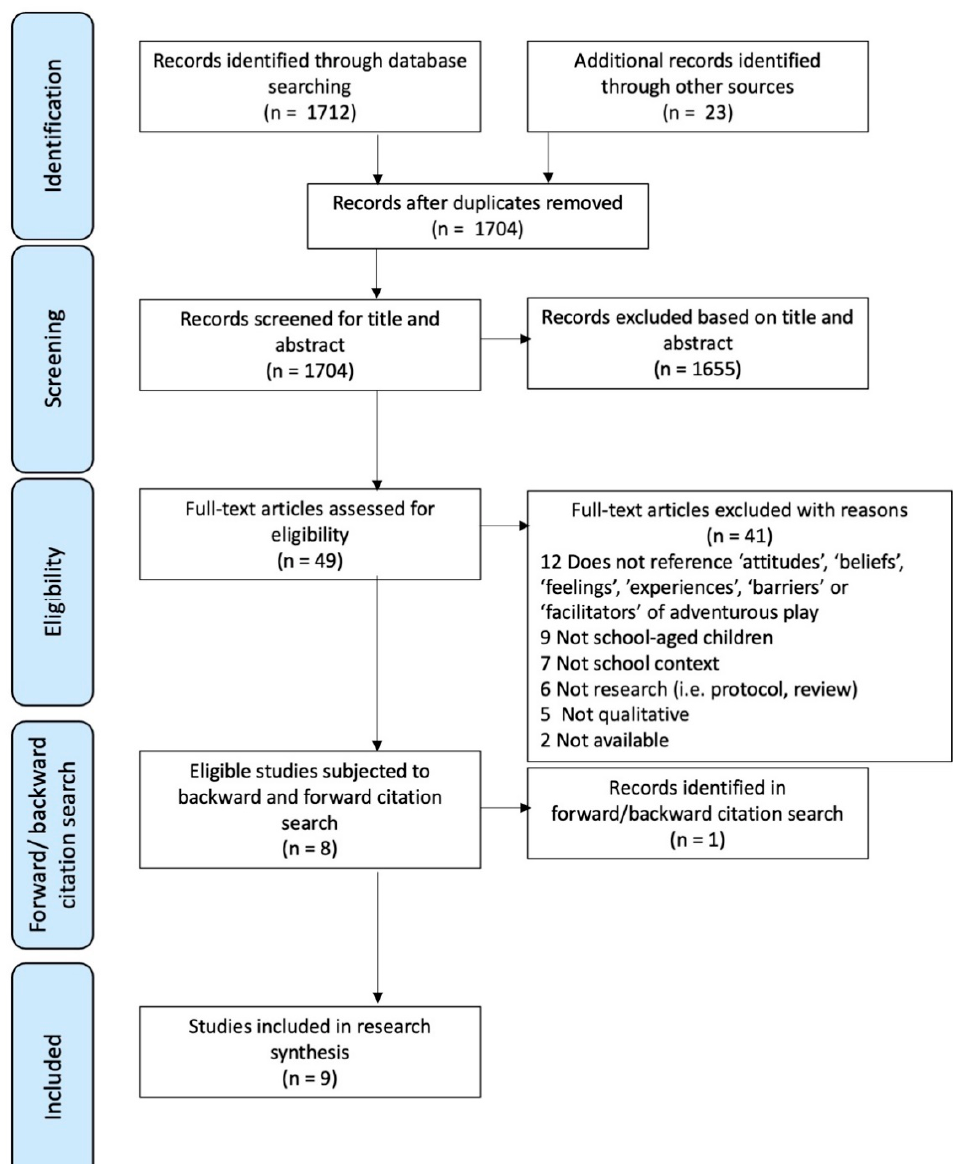
Figure 1. PRISMA diagram, detailing the number of records at each stage of the systematic review process.